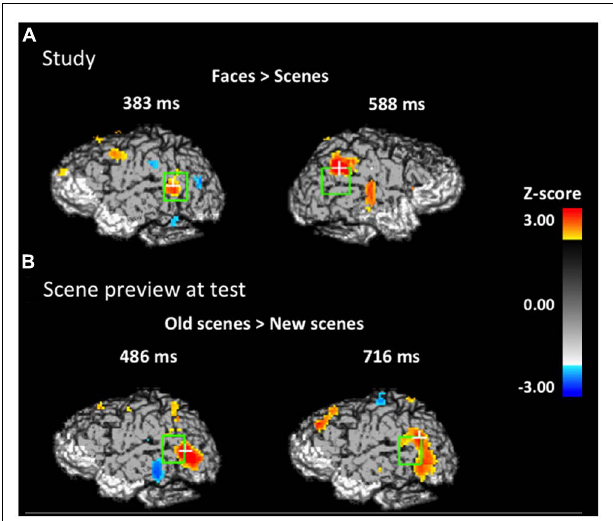
FIGURE 3 | Spatial maps based on group-level Z -statistics of the EROS data projected on sagittal brain surfaces. Dark gray shading represents the brain area sampled by the recording montage.The light green rectangle indicates the STS ROI and the white cross marks the peak resel within the ROI. (A) Activity during study trials for face-first trials versus scene-first trials in the left STS at 383 ms and in the right STS at 588 ms. (B) Activity during the scene preview for previously studied scenes versus completely novel scenes in the left STS at 486 ms and 716 ms.